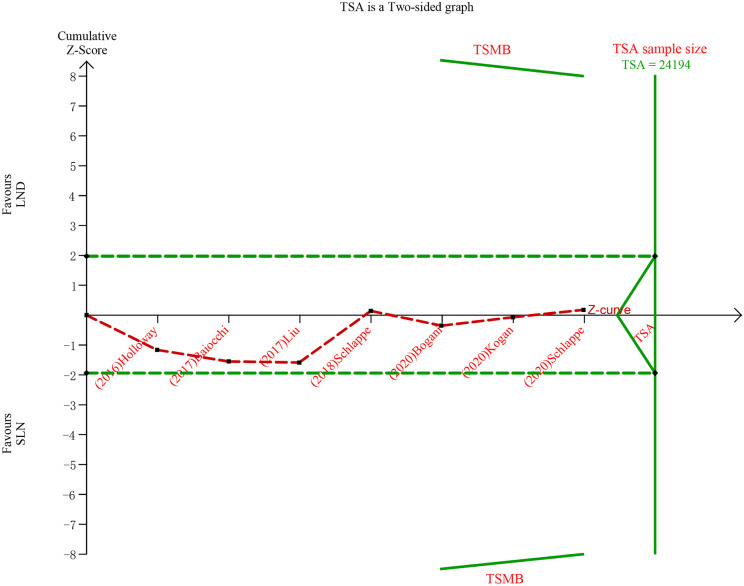
TSA of para-aortic lymph nodes, α = 0.05, β = 0.8, relative risk reduction = 15.4%, incidence in control group = 9.2%, two-sided test.